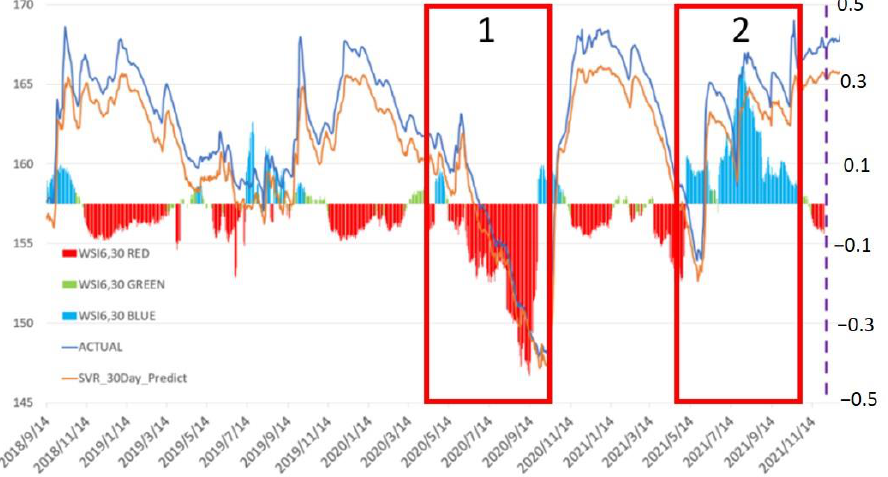
Figure 8. Analysis result of WSI 6,30 .